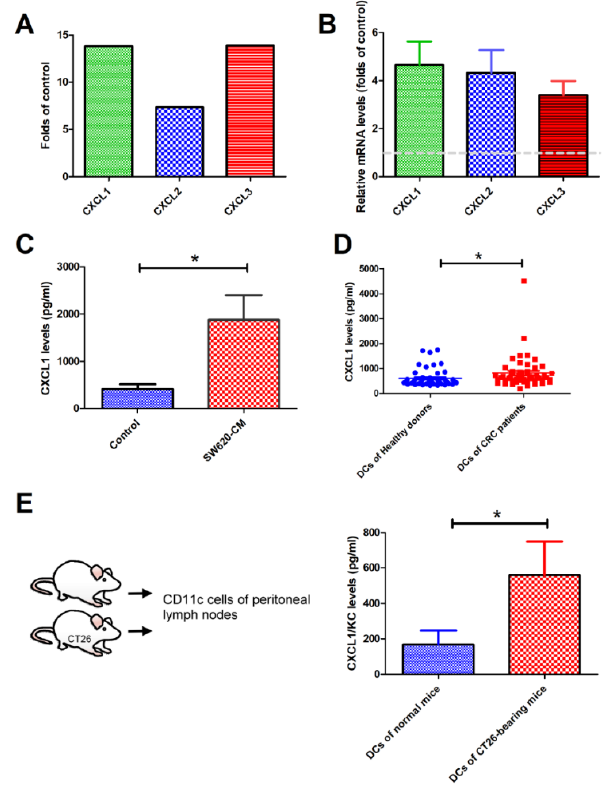
Figure 2. Upregulation of CXCL1 in DCs isolated from mice and patients with CRC. Increased CXCL1, CXCL2 and CXCL3 ( A ) in SW620-conditioned TADCs, as determined by microarray. Elevated CXCL1 in SW620-conditioned TADCs at mRNA ( B ) and protein ( C ) levels. TADCs were generated by culturing CD14 + monocytes with RPMI, L-15 medium (50%), and SW620-CM (50%) and presenting in GM-CSF (10 ng/mL) and IL-4 (10 ng/mL) for five days. The expressions of mRNA and protein were assessed by microarray, qRT-PCR and Luminex assays. ( D ) The level of CXCL1 in the DCs isolated from patients with CRC. CD11c + cells were isolated from healthy donors and patients with CRC, and the levels of CXCL1 were measured by Luminex assay. ( E ) The levels of CXCL1 in DCs isolated from colon cancer-bearing mice. Mouse colon cancer CT26 cells were injected into mice via intraperitoneal injection. After 14 days, peritoneal lymph nodes were harvested. CD11c + DCs were isolated from the lymph nodes, and the culture medium collected after 24 h incubation. CXCL1 levels were determined by ELISA. Results are representative of at least three independent experiments. Each value is the mean ± SD of three determinations. * Significant difference between the two test groups ( p < 0.05) (*).